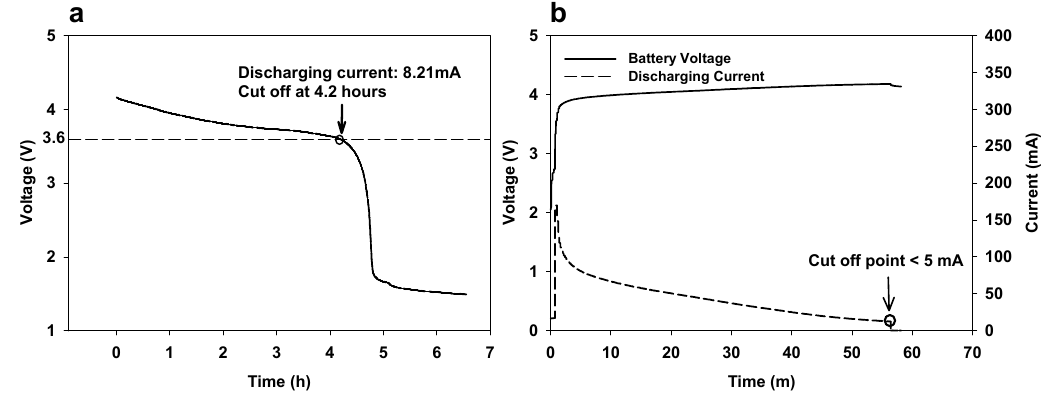
Figure 4. Battery discharging curve ( a ) and charging curve ( b